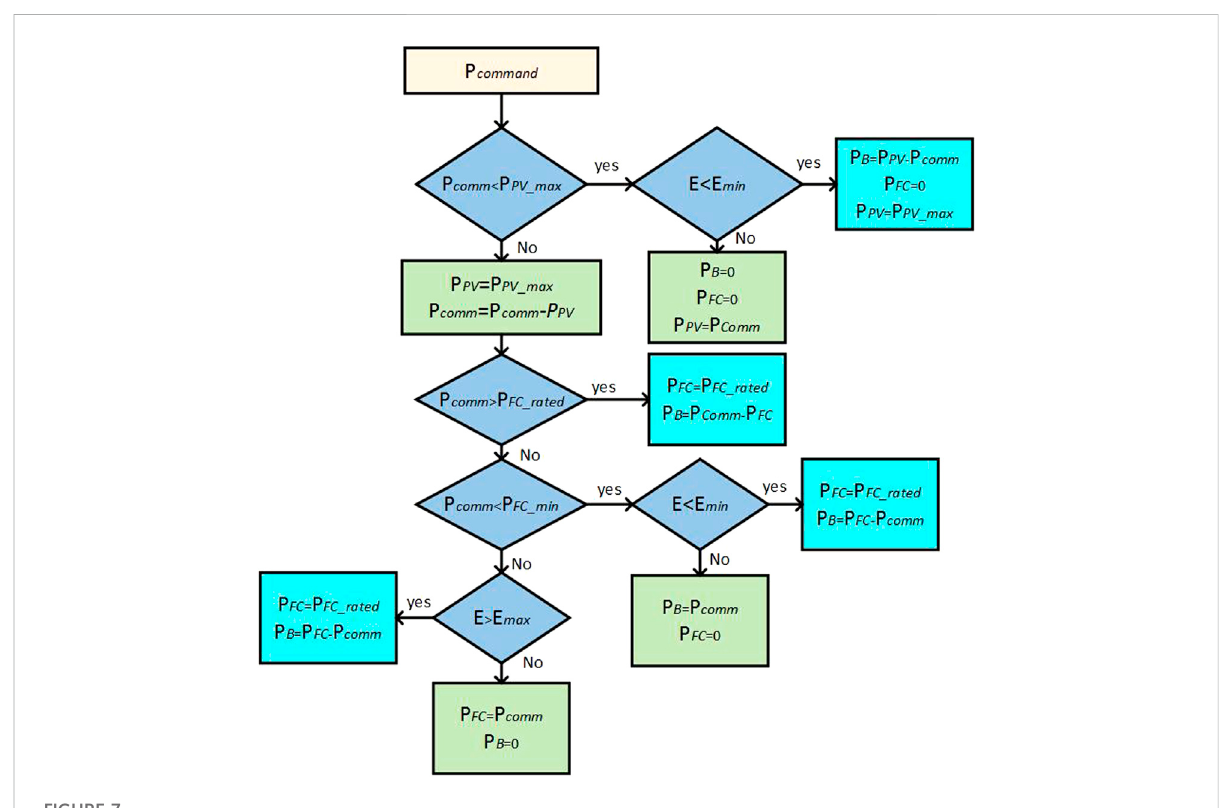
FIGURE 7 Flowchart of the proposed converter.